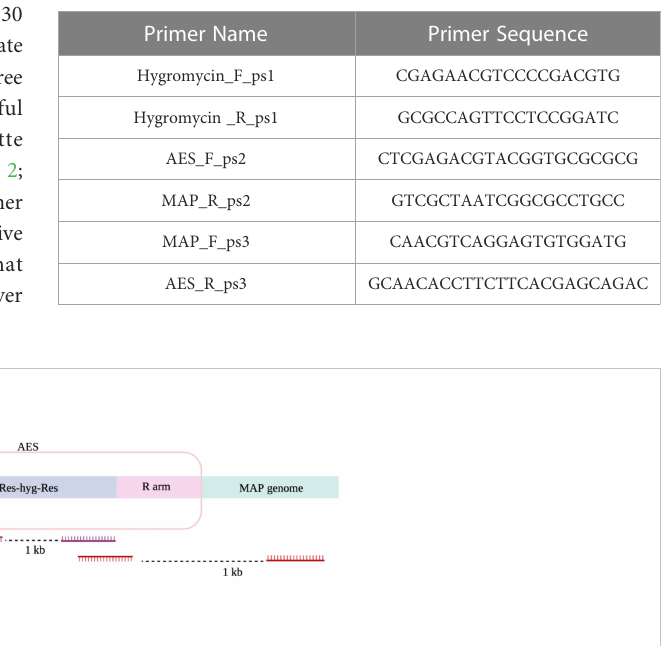
TABLE 1 Primers for screening MAP